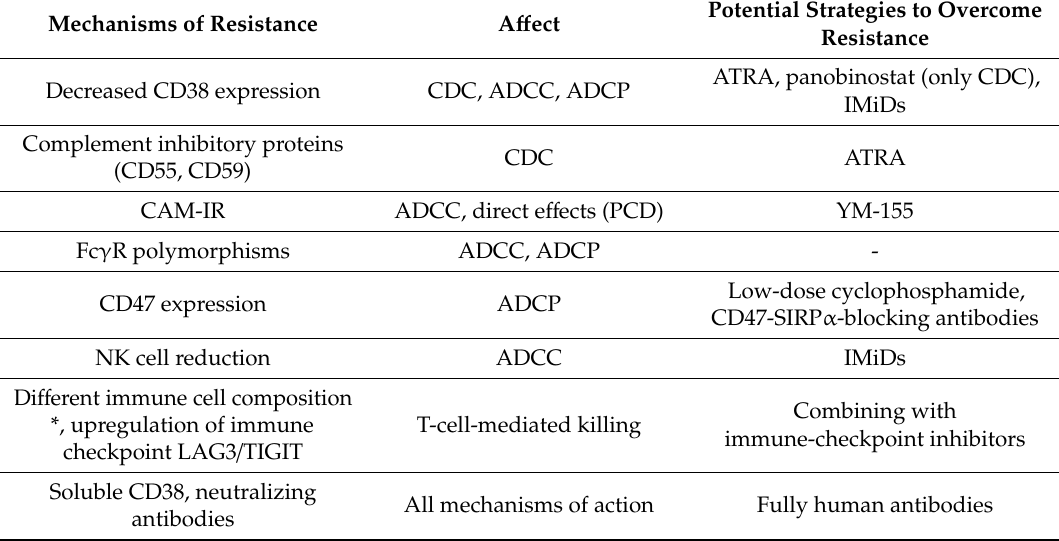
Table 2. Schematic overview of mechanisms of resistance and potential strategies to overcome this. Mechanisms of